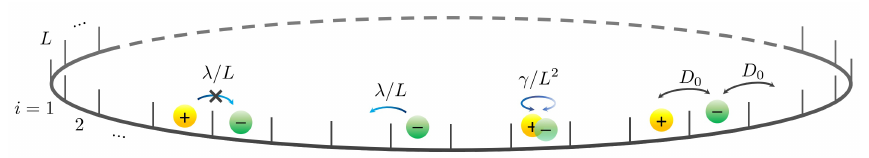
Figure 1: Schematic representation of the microscopic dynamics of the active lattice gas model. Particles self-propel with rate λ/ L to vacant sites and tumble at rate γ/ L 2 . They also perform diffusive swap with an occupied or vacant neighbor at equal rate D 0